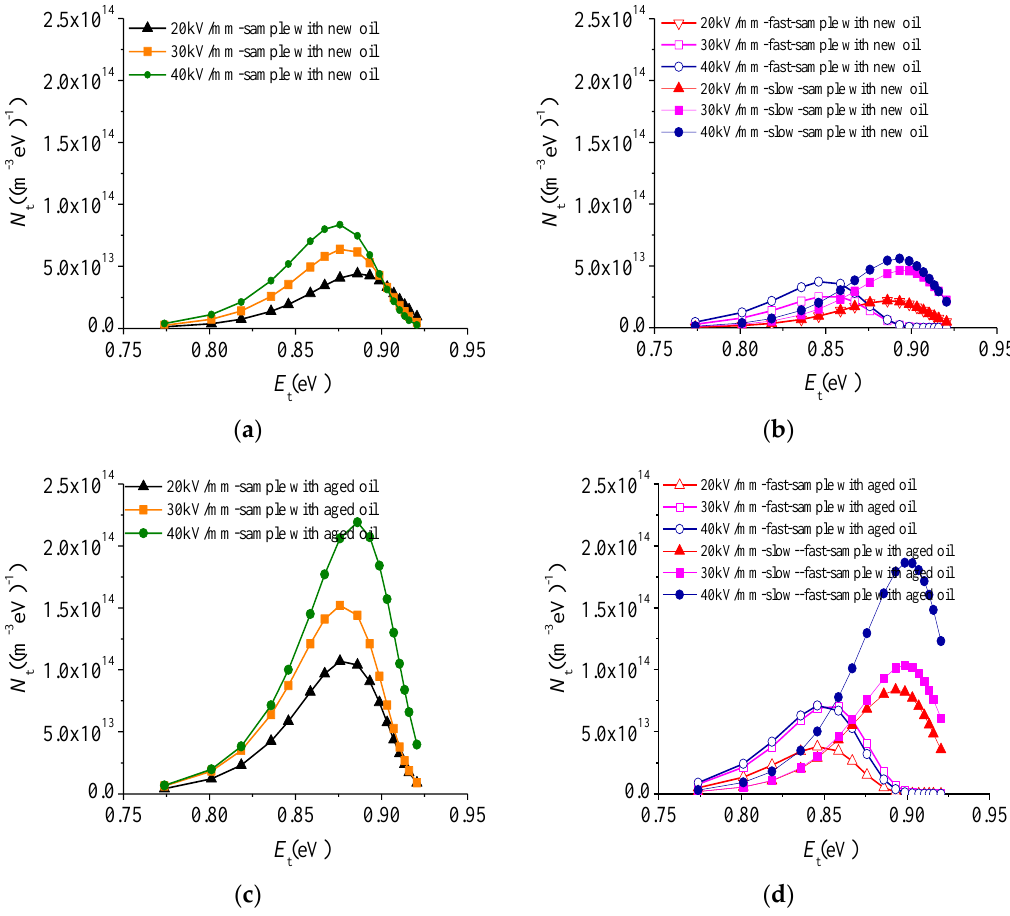
Figure 8. Calculation result of trap distribution by using the common method and the improved method for oil impregnated insulation paper with new oil and aged oil. ( a ) common method: sample with new oil; ( b ) improved method: sample with new oil; ( c ) common method: sample with aged oil; ( d ) improved method: sample with aged